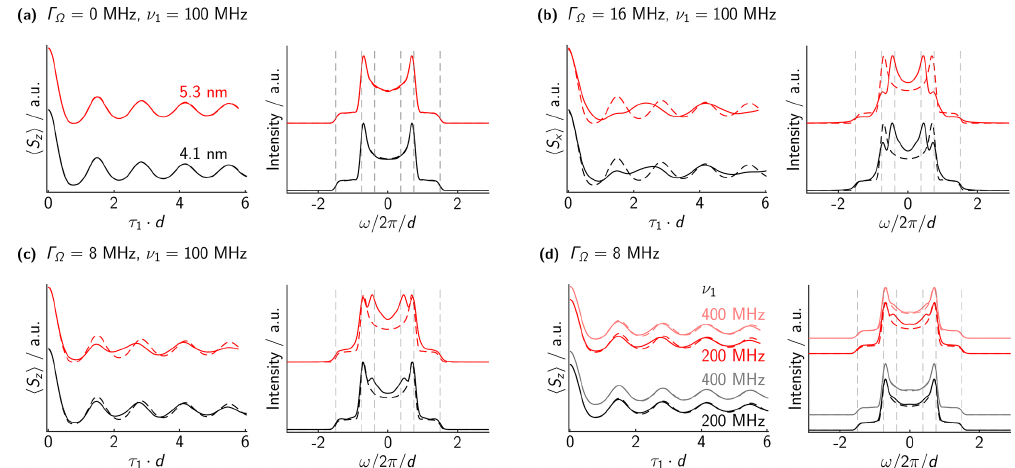
Figure 6. Numerical simulations with different dipolar couplings, offset distributions, and Rabi frequencies. Time and frequency axes are scaled by the dipolar coupling to facilitate comparison. Dashed lines represent the analytical Pake pattern (with the frequency scaled by 3 / 4). (a) No offsets at all, 100MHz Rabi frequency. The numerical simulation of the spin lock completely matches the analytical expectation. (b) Gaussian offset distribution with FWHM of 16MHz, 100MHz Rabi frequency. The numerical simulations deviate from the analytical expectation. In the frequency domain, “artifacts” appear at lower frequencies, around 3 / 8 · ν ⊥ . (c) Same as (b) but with a reduced offset FWHM of only 8MHz. The intensity of the artifacts is reduced compared to larger offset distributions. (d) Same as (c) but with increased Rabi frequencies. The intensity of the artifacts is again reduced compared to smaller Rabi